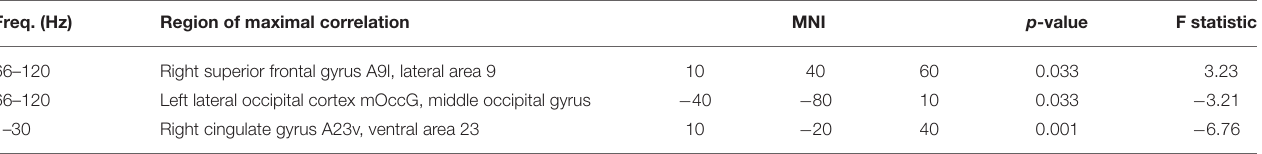
TABLE 1 | Contrasting brain activity in the collaborative and individual conditions. Freq. (Hz)